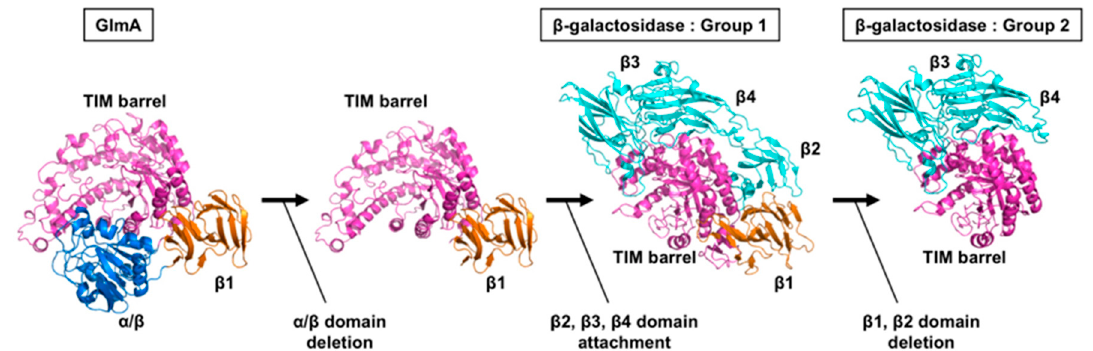
Figure 7. Hypothetical evolutionary pathway from GlmA to GH35 β -galactosidases. TIM-barrel domain, α / β : domain, β 1 domain, and β 2– β 4 domains are colored magenta, blue, orange, and cyan, respectively.